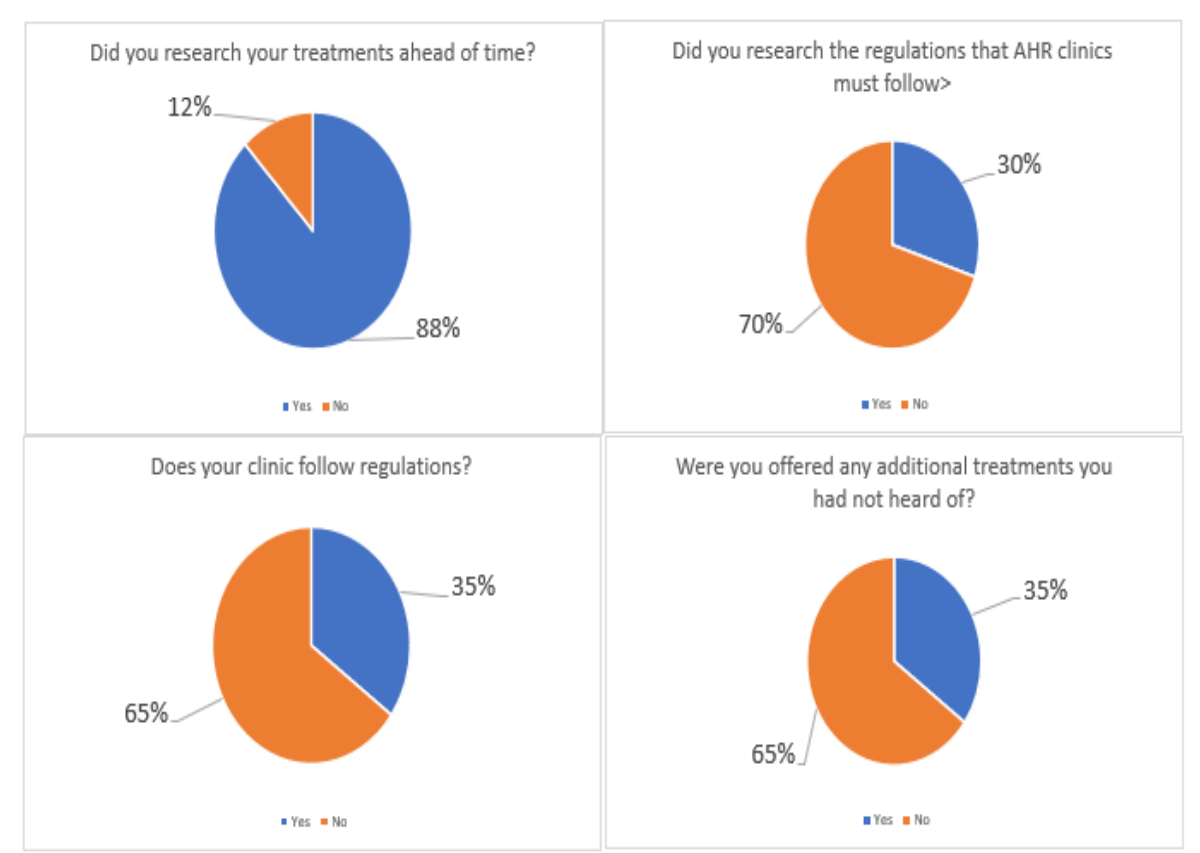
Figure 4. Questions about the respondents knowledge of the treatment and regulations around their AHR journey. AHR